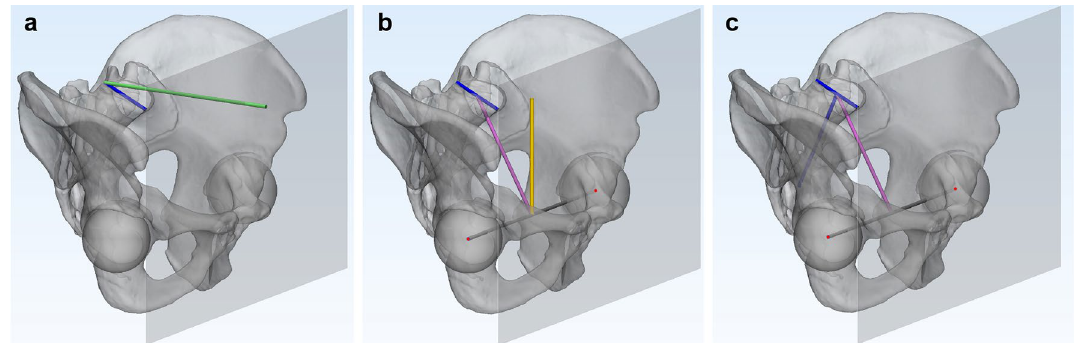
Figure 5. Representation of 3D pelvic parameters. The transparent grey pelvis indicates a pelvis in a random position. The transparent grey plane indicates a vertical plane parallel to the bicoxofemoral axis. The red dots indicate the centers of both femoral heads. The green bar indicates the normal axis of the vertical plane. The yellow bar indicates the vertical axis. The short blue bar indicates the line connecting the most anterior and posterior points of the sacral upper endplate. The long blue bar is a line perpendicular to the short blue bar. The pink bar connects the midpoint of the blue bar and the midpoint of the bicoxofemoral axis. MIMICS 20.0 (Materialise, Leuven, Belgium) and 3-matic 12 (Materialise) were used to create the image. ( a ) The sacral slope is the angle between the green and blue bars. ( b ) The spinopelvic tilt is the angle between the pink and yellow bars. ( c ) The pelvic incidence is the angle between the long blue and pink